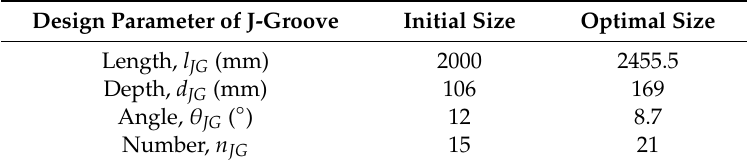
Table 11. Comparison of design parameter size of J-Grooves for draft tube shape